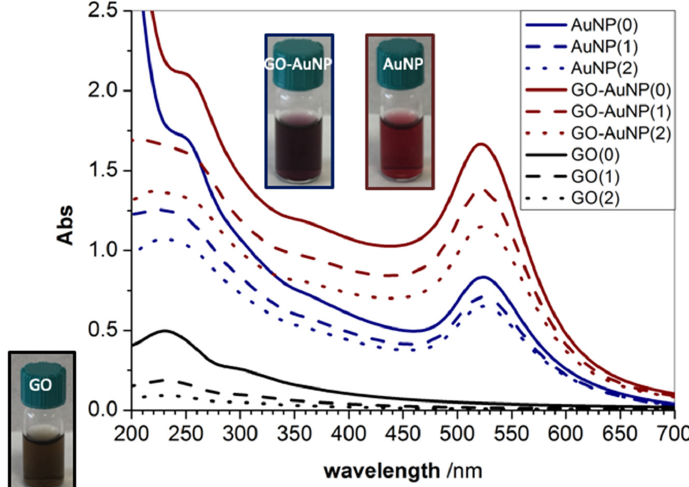
Figure 1. UV-visible spectra of graphene oxide gold nanoparticles (GO-AuNP) (blue) and AuNP (wine) samples before (‘0’) and after the two rinsing steps in Milli-Q water (centrifugation at 8,000 r.p.m, 15 min, RT) for the re-suspended pellets 1 (‘1’) and 2 (‘2’), respectively. Spectra of GO (black) before (‘0’) and after two rinsing steps in Milli-Q water (centrifugation at 13,000 r.p.m, 20 min, RT) for the re-suspended pellets 1 (‘1’) and 2 (‘2’) are shown for